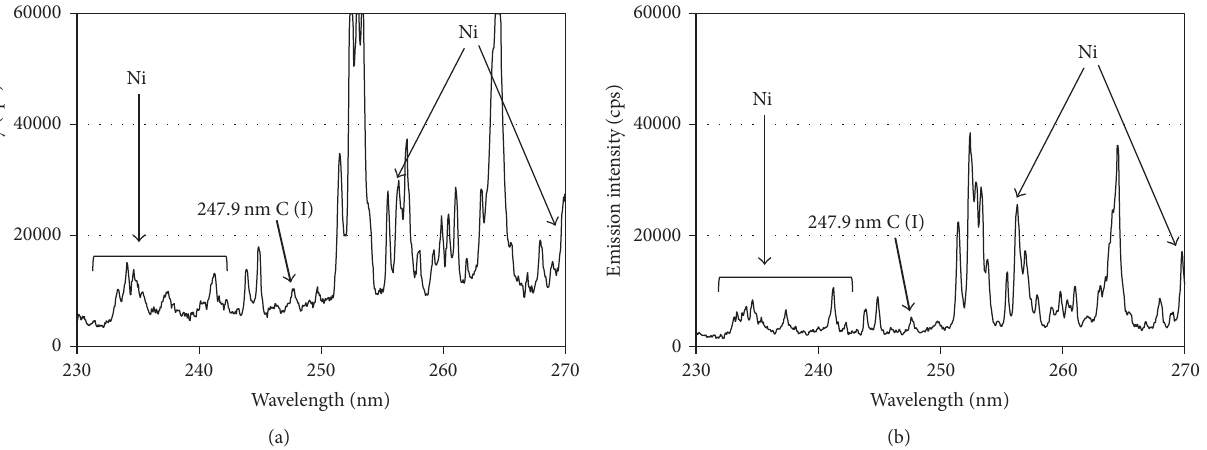
Figure 4: LIBS spectra observed for Ti under (a) Ar and (b) He chamber gas conditions. The emission spectra without indication of element were originated from